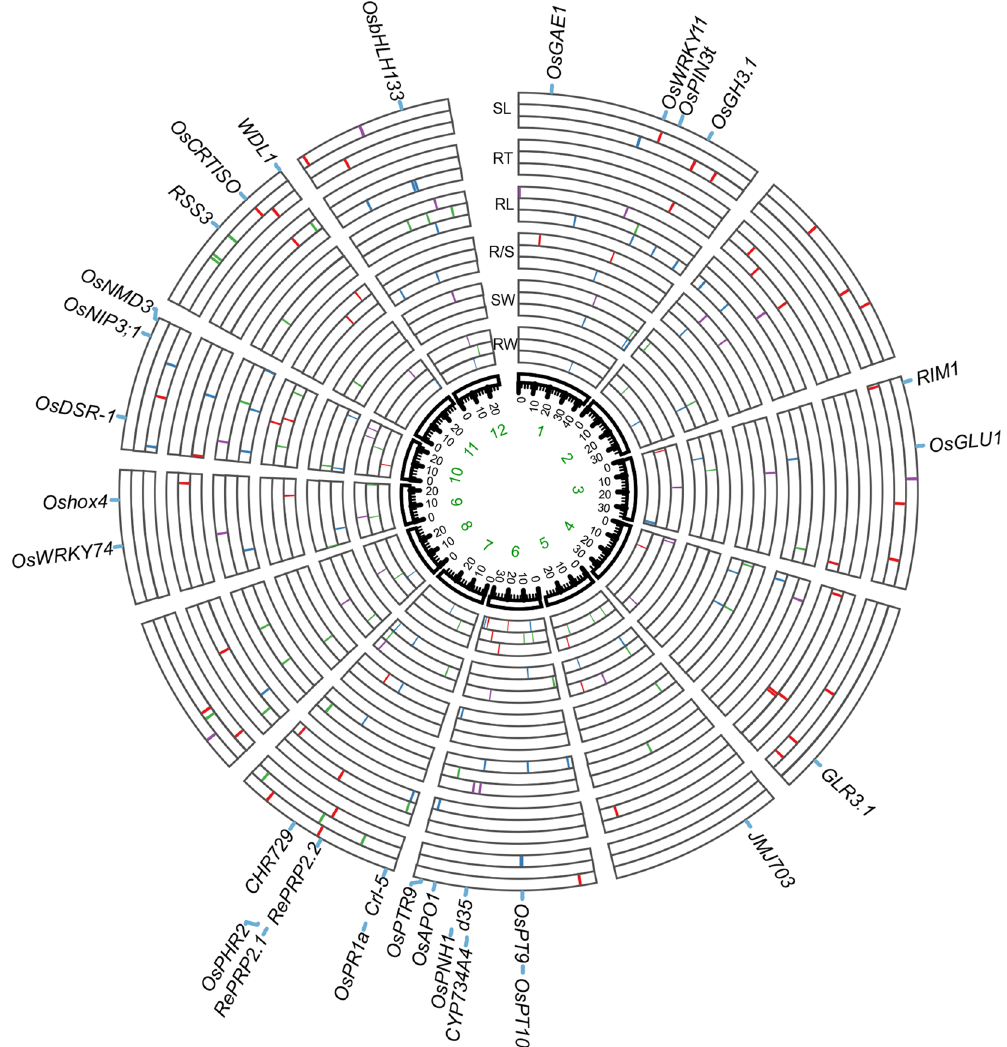
Figure 2. Circos map of all association signals for six traits of rice seedling biomass in the full population (inner layer), indica (middle layer) and japonica (outer layer). Signals identified in full population, indica and japonica are colored in blue, green and violet, and signals colored red show QTLs have observed in previous studies. Thirty known genes around the association signals are labeled in the outermost